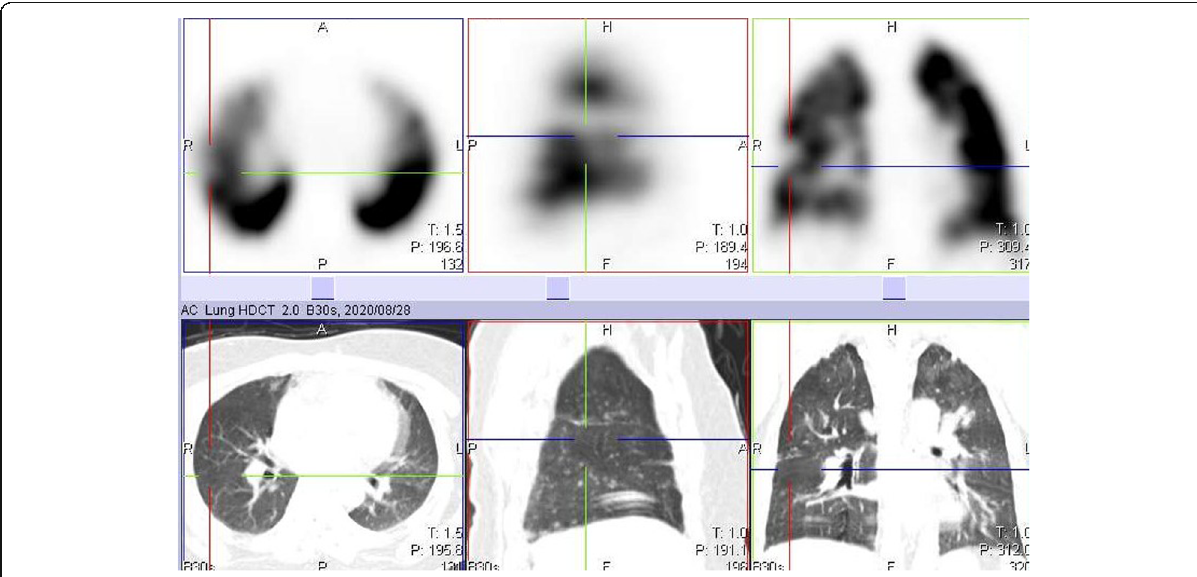
Fig. 2 Axial, coronal and sagittal SPECT images of the lungs showing a large perfusion defect in the lateral segment of the right middle lobe. The corresponding CT images below do not show obvious structural lung changes in that